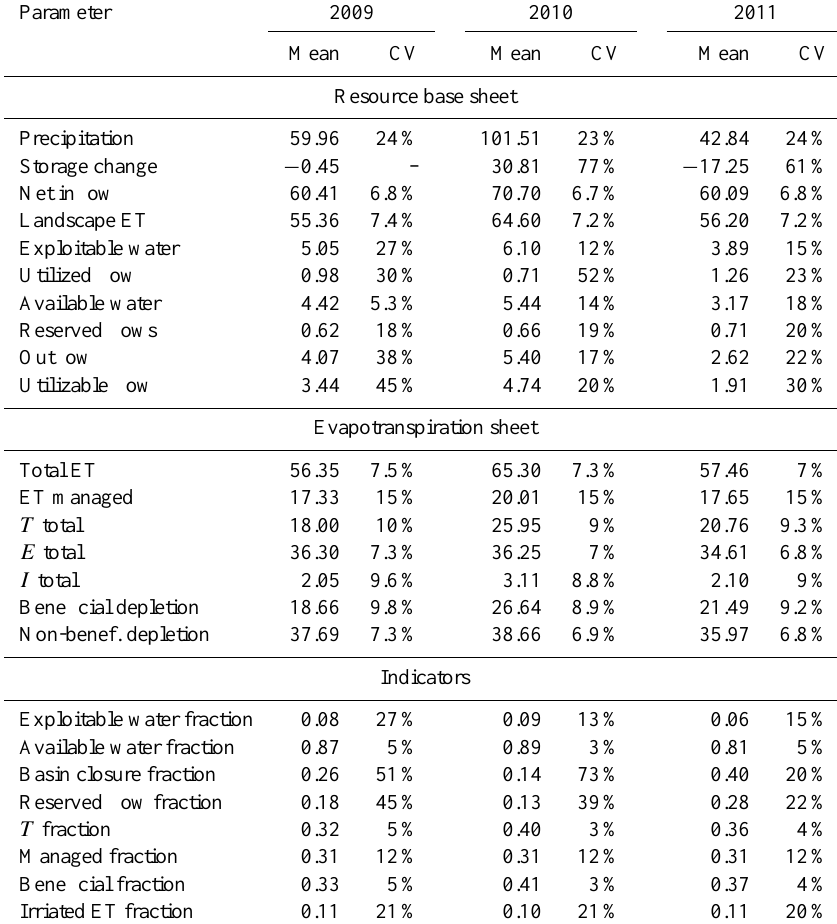
Table 9. Temporal variability of WA + across a longer period with low and high rainfall